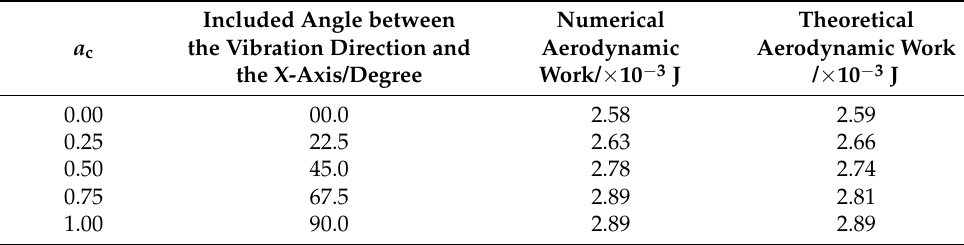
Table 6. Aerodynamic work of the coupled modes.